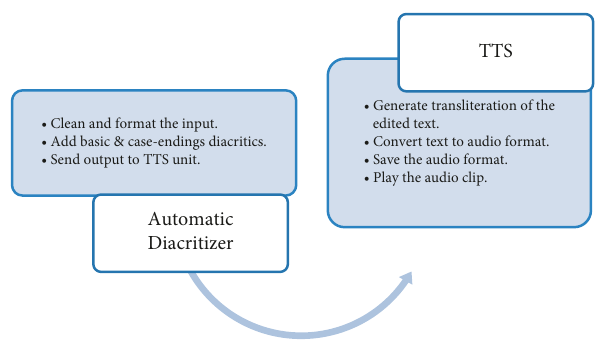
Figure 5: Units of the proposed system.